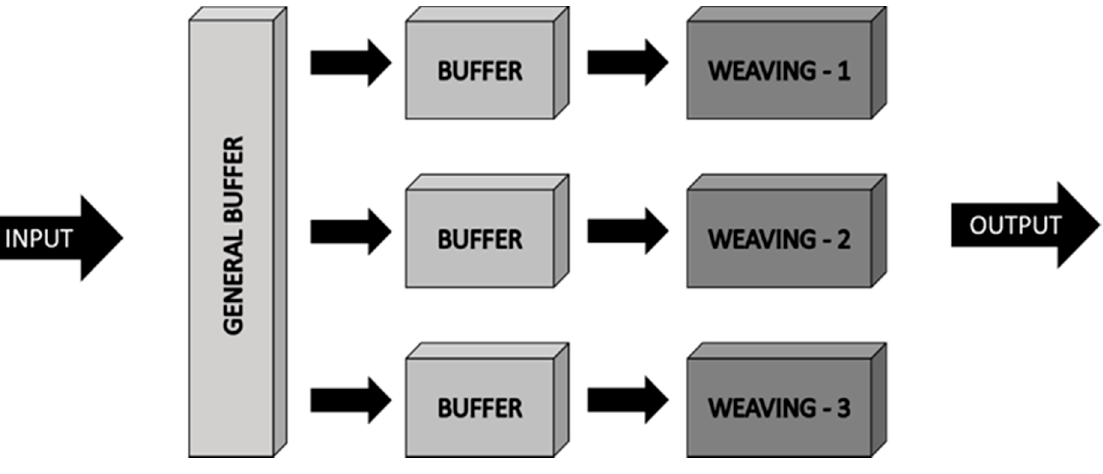
Figure 2. Flow of materials through the manufacturing processes.